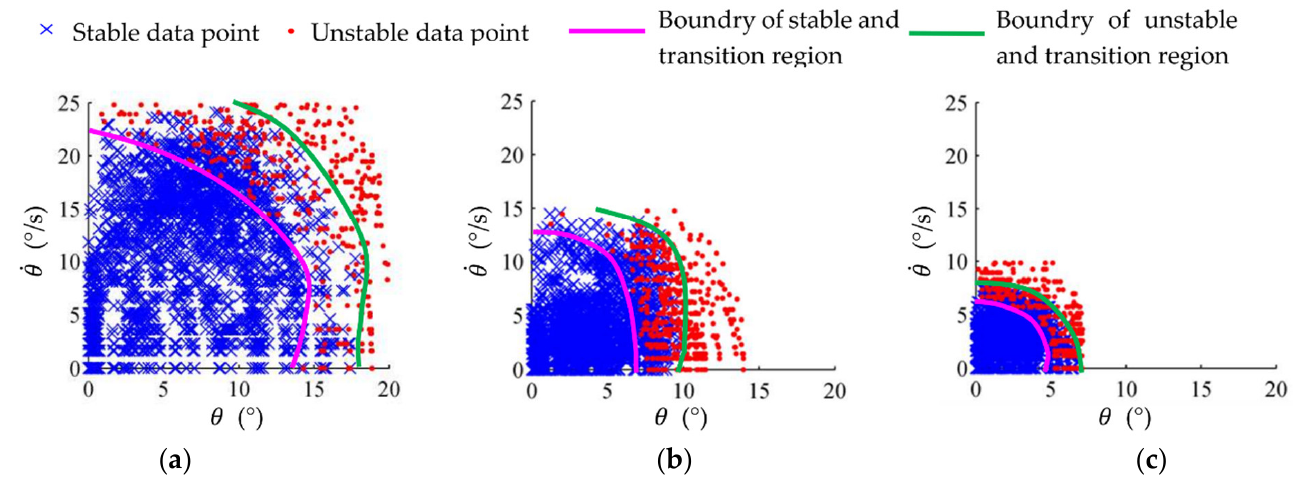
Figure 18. Data distributions in motion platform phase space. ( a ) Double-leg stance; ( b ) single-leg stance; ( c ) stepping.